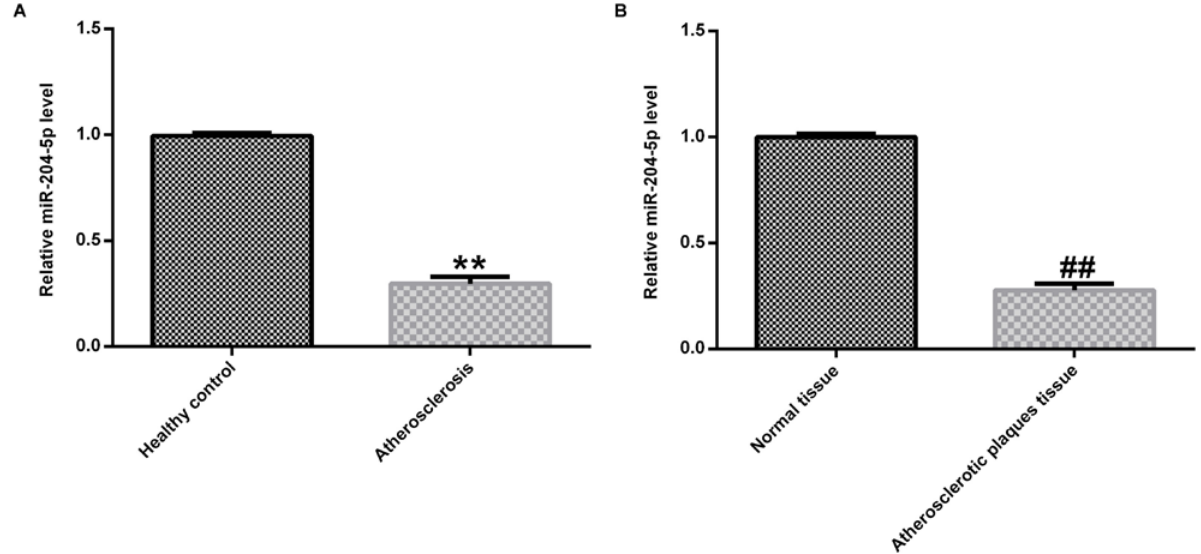
Figure 1: The low expression of miR-204-5p in atherosclerotic tissues and blood. (A) The expression levels of miR-204-5p in blood from 30 atherosclerotic patients and 30 healthy subjects were determined by qRT-PCR assay. (B) The expression levels of miR-204-5p in 30 atherosclerotic plaque tissues and 30 normal control tissues were detected by qRT-PCR assay. Data were exhibited as mean ± SD.**p <